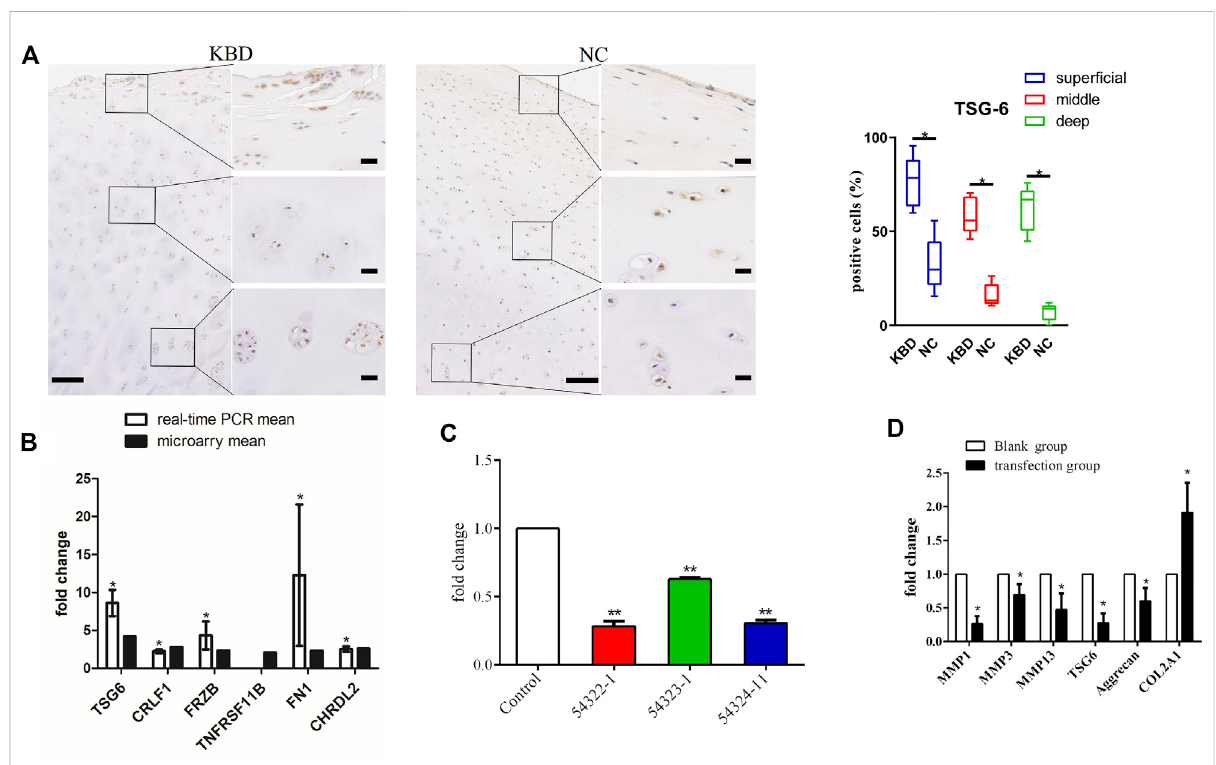
FIGURE 1 (A) Representative immunohistochemistry staining of TSG-6 in KBD and healthy cartilage tissues. Scale bar, left, 500 μ m; right, 50 μ m, and comparative quanti fi cation of positive cells of different areas (super fi cial, middle, and deep) between KBD and healthy cartilage tissues displayed by boxplot( n =3).* p < 0.05. (B) ThemRNAlevelsoftheselectedgenesbetweenthemicroarrayandquantitativeRT-PCRinchondrocytesfrompatients with KBD ( n = 3) and normal controls ( n = 3). The histogram shows the fold change of selected genes as measured by microarray and quantitative RT-PCR; * indicates p < 0.05. (C) The selection of an optimistic transfection target for TSG-6, and the interference effect of TSG-6RNAi target sequence interfered with RNAi and detected by quantitative RT-PCR; ** indicates p < 0.001. (D) The mRNA levels of MMP1, MMP3, MMP13, aggrecan, and COL2A1 after silencing TSG-6; * indicates p < 0.05.